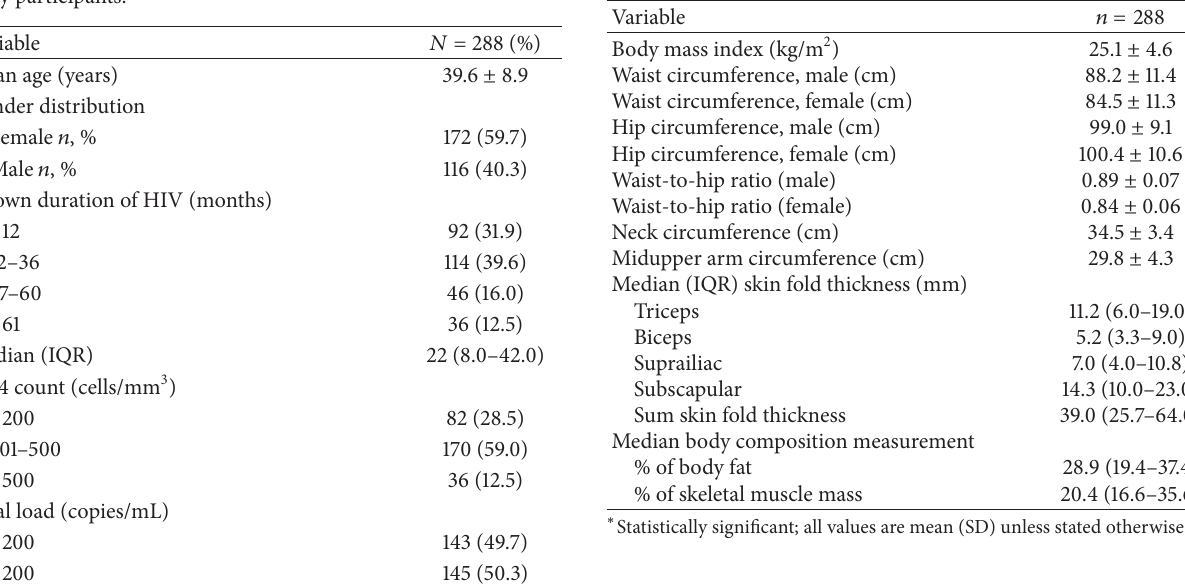
Table 2: Anthropometric indices in the study participants.